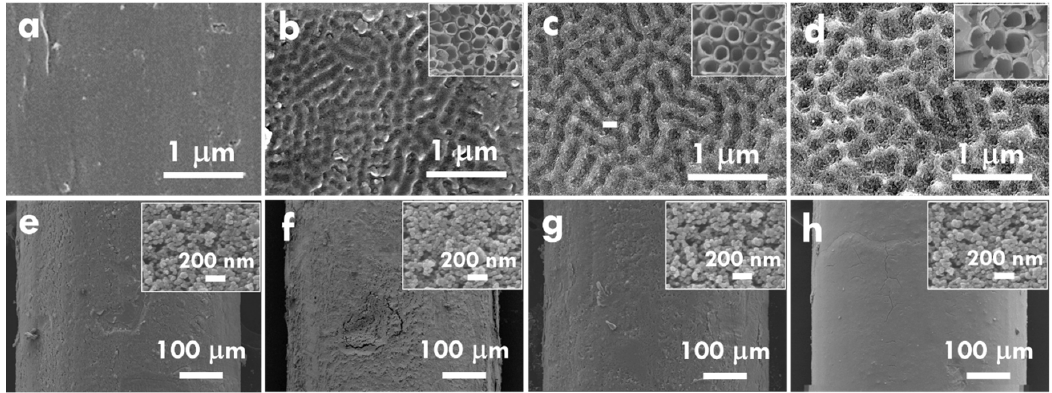
Figure 2. The SEM image of ( a ) Ti wire and the TNT-printed Ti wire prepared using ( b ) 30, ( c ) 40, and ( d ) 50 V; the SEM image of ( e ) TNP / Ti wire and the TNP / TNT-printed Ti wire prepared using ( f ) 30, ( g ) 40, and ( h ) 50 V.